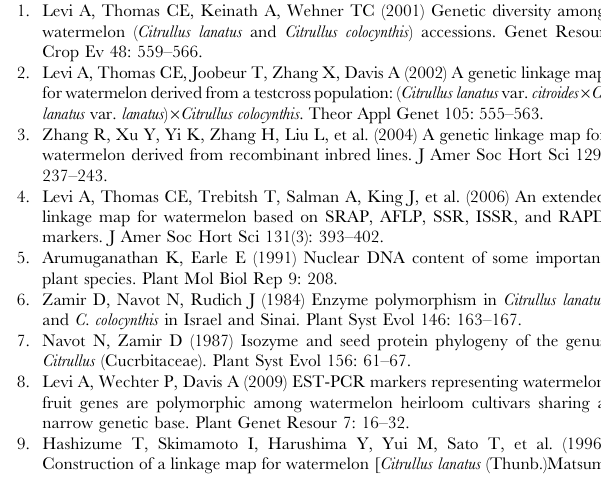
Table S1 SSR, InDel and SV markers used to construct the saturated genetic map of watermelon for scaffold anchoring. Their chromosome, bin position, genetic distance (cM), marker name, repeat motif, scaffold name, primer start, primer end, production size from 97103 and primer sequences are listed. Table S2 Selected BACs for assigning linkage groups to chromosomes. Marker name, genetic distance, corresponding scaffolds, unique signal BACs and BACs/45S/5S for assigning LGs to chromosomes are